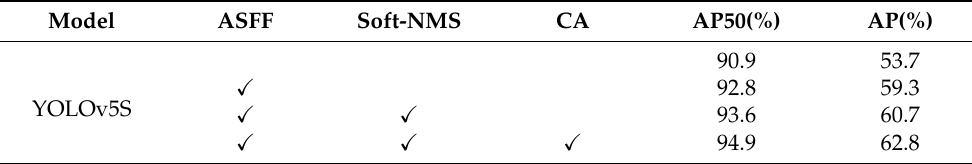
Table 2. Comparison of experimental results of improved